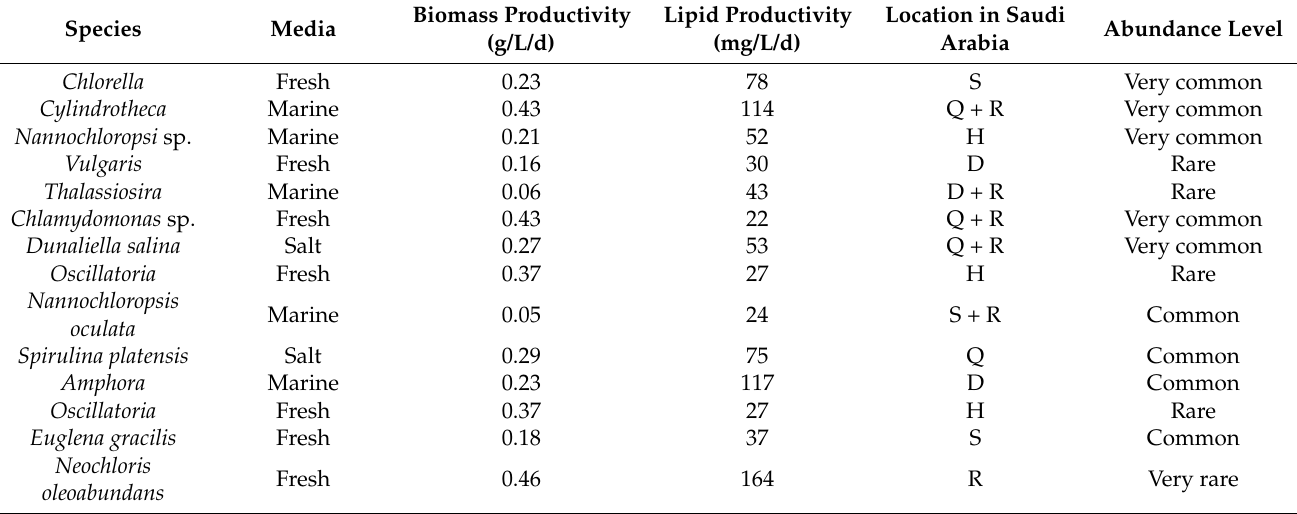
Table 1. Biomass and lipid productivities of various microalgae found on Saudi Arabia’s eastern and western coastlines [8–12].